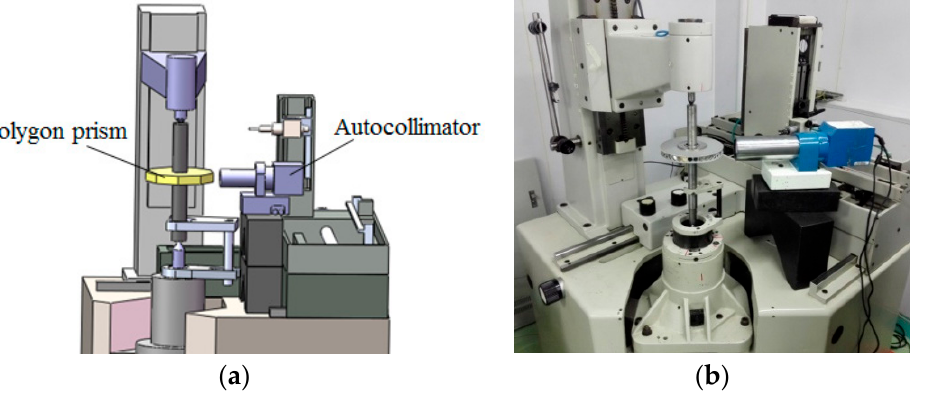
Figure 11. Measurement of angular indexing error of the mandrel: ( a ) the method using the polygon and autocollimator; ( b ) a photo of the experimental setup.